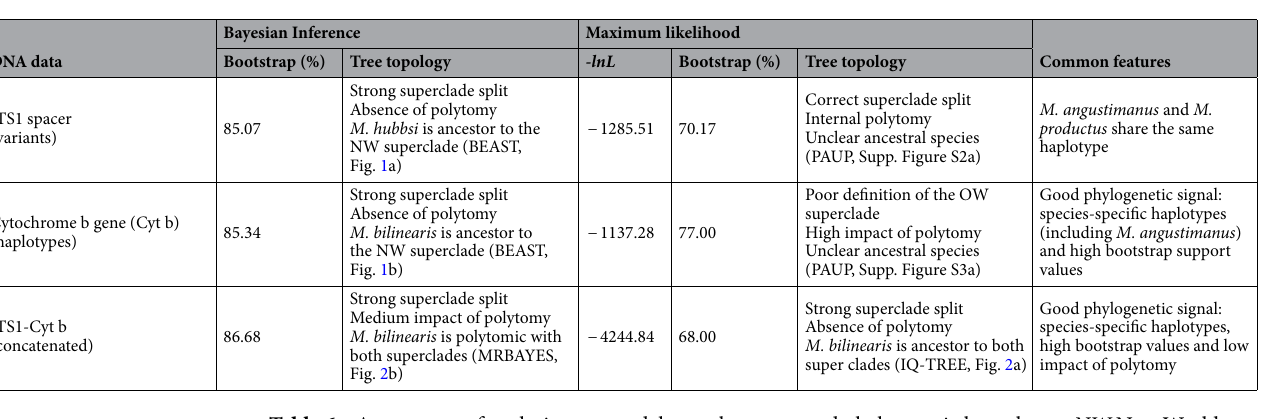
Table 6. Assessment of evolutionary models, marker types and phylogenetic hypotheses. NW New World hakes; OW Old World hakes. The bootstrapping values are averaged figures within trees.